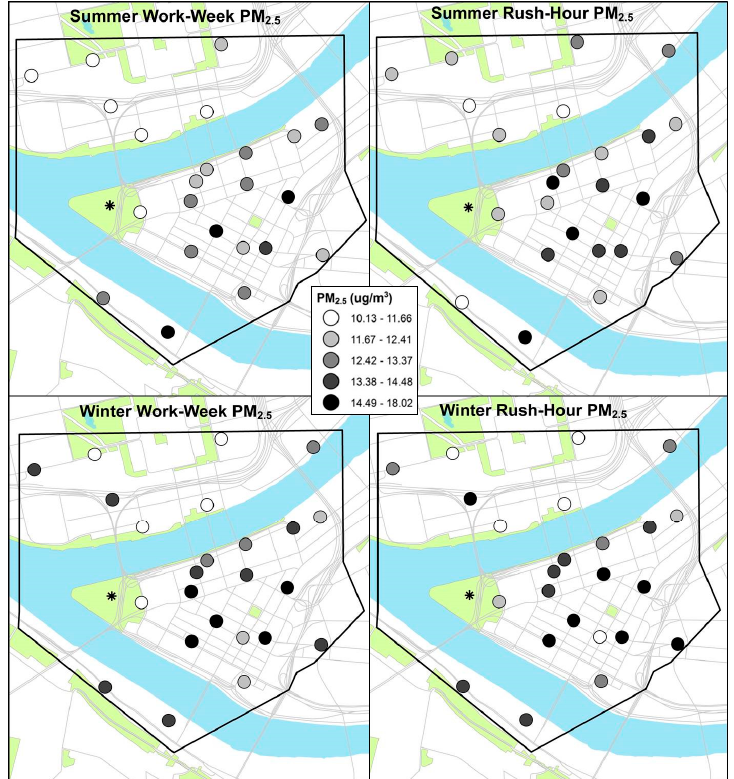
Figure 2. Paired work-week and rush-hour temporally-adjusted PM 2.5 concentrations (in quintiles) across 24 distributed monitoring sites for summer ( top ) and winter ( bottom ) sampling.